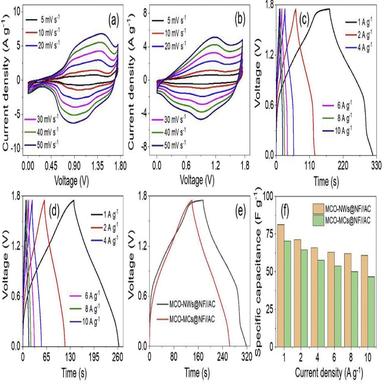
The CV curves of (a) MCO-NWs@NF//AC HSC and (b) MCO-MCs@NF//AC HSC at various scan rates, the GCD curves of (c) MCO-NWs@NF//AC HSC and (d) MCO-MCs@NF//AC HSC at different current densities, (e) the GCD curves at 1 A g¡1 for MCO-NWs@NF//AC HSC and MCO-MCs@NF//AC HSC, and (f) the rate performance of the two HSCs.